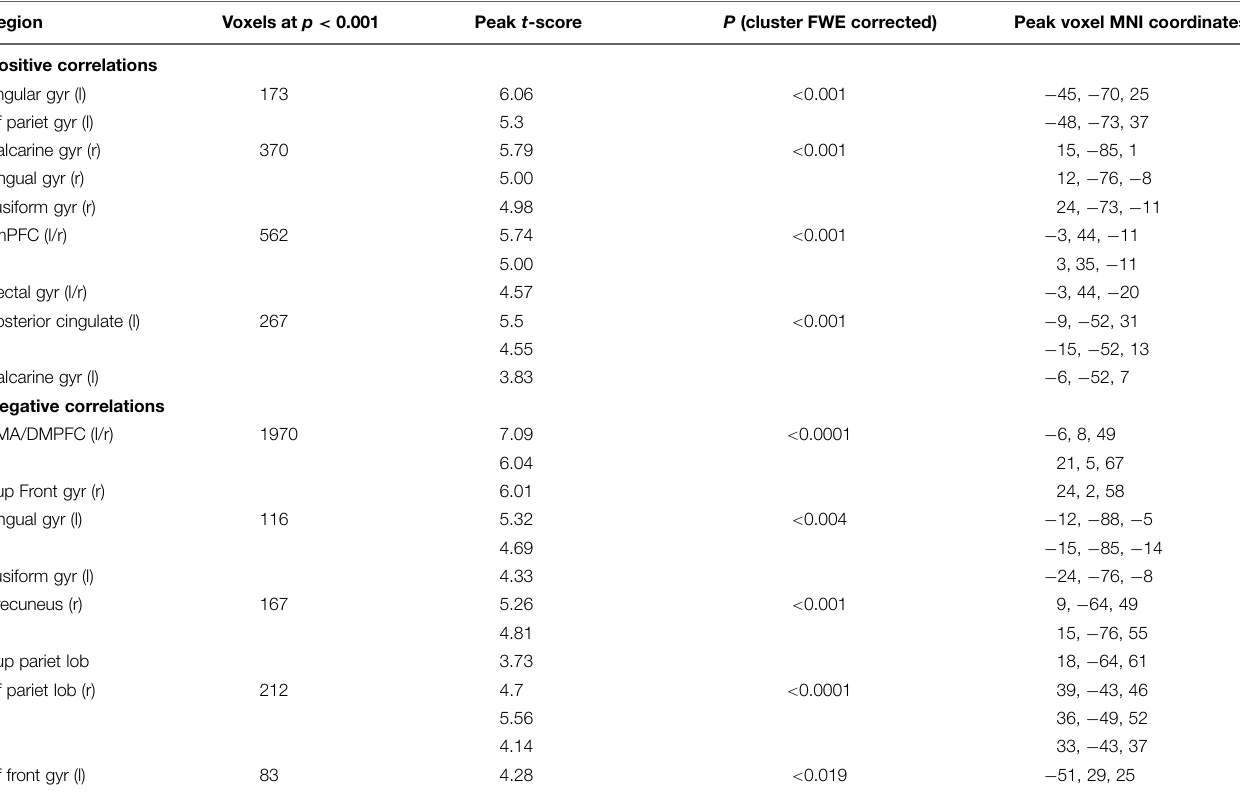
TABLE 3 | Areas showing significant correlations with subjective certainty ratings in motion trials (cluster-defining threshold p < 0.001, uncorrected; reported changes in BOLD signal corrected for multiple comparisons at p < 0.05, whole brain corrected). Region Voxels at p < 0.001 Peak t -score P (cluster FWE corrected) Peak voxel MNI coordinates